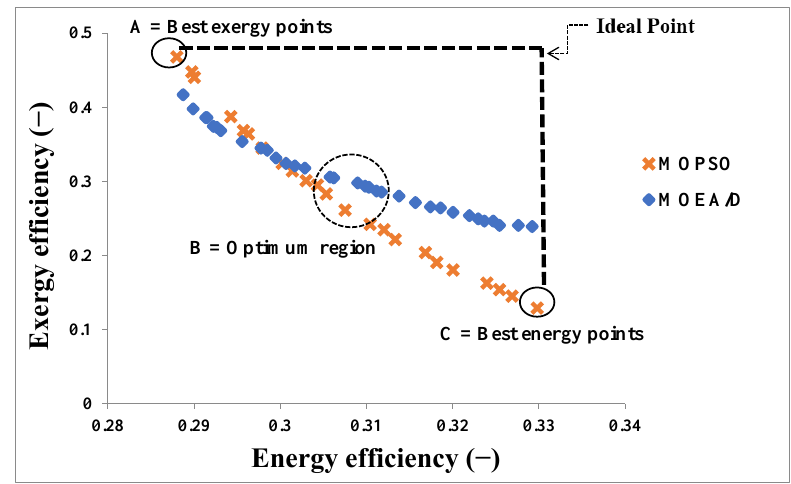
Figure 9. Comparing the optimal points between the MOPSO and MOEA/D approaches.